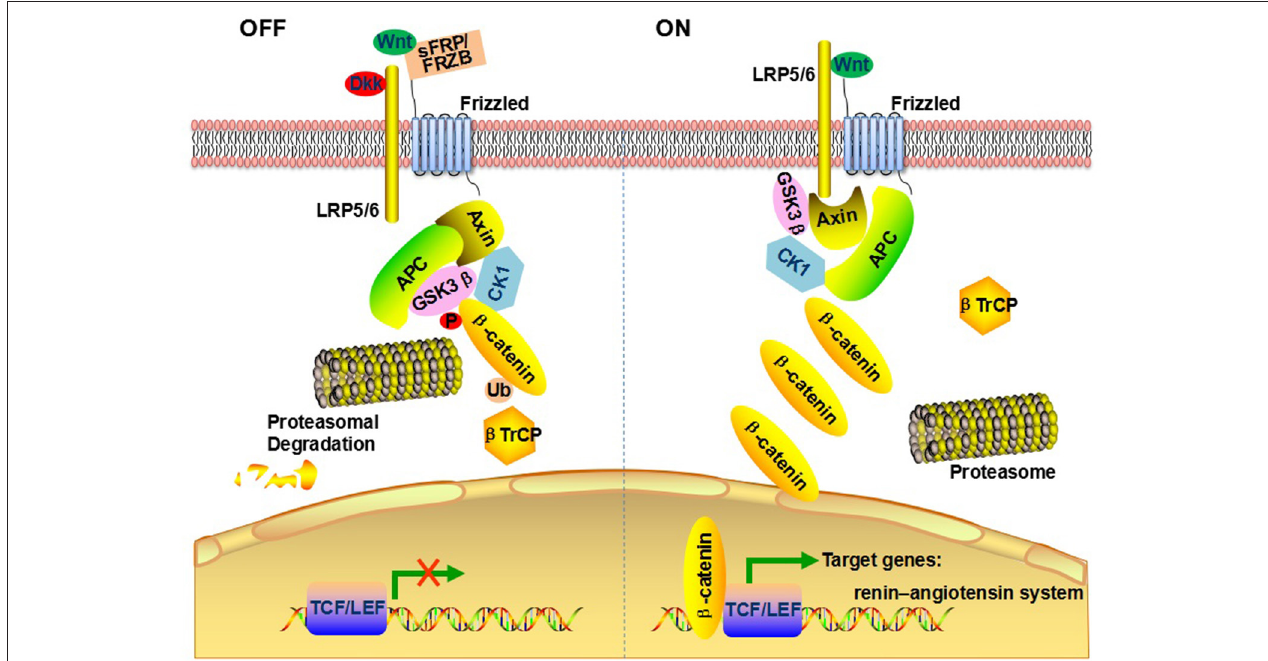
FIGURE 3 | Schematic summary of Wnt/ β -catenin signaling